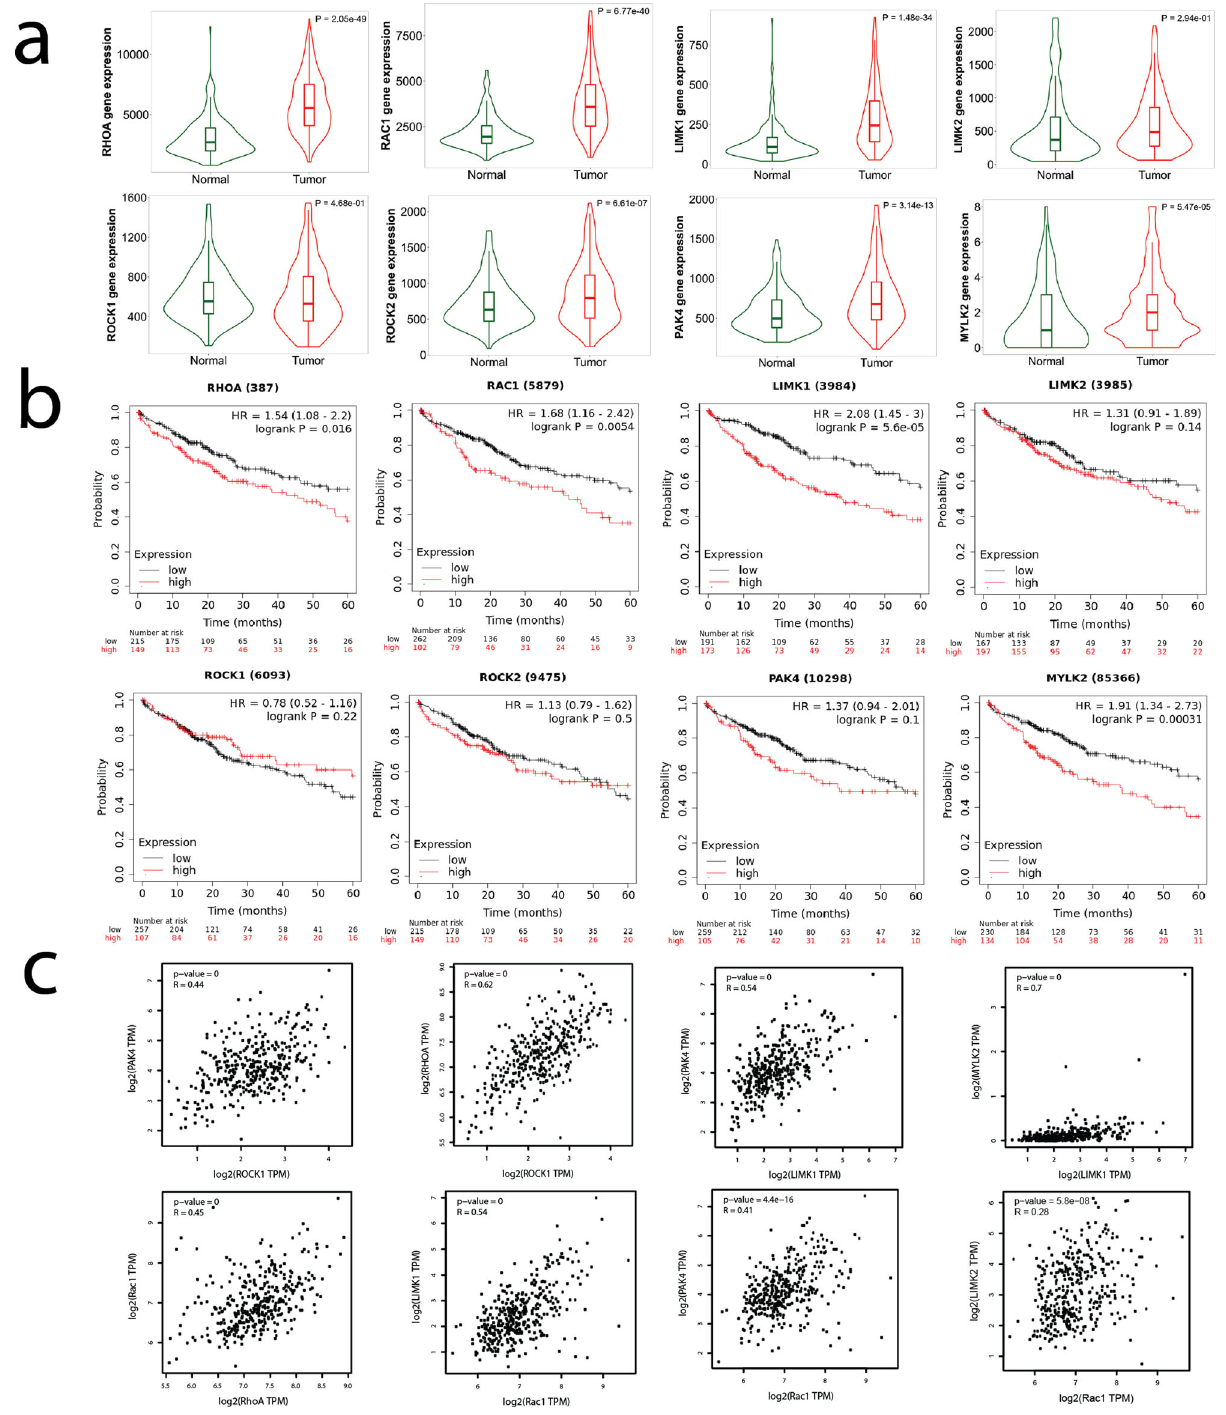
Fig. 7 Rho family of small GTPases, PAK4, LIM kinase, and myosin light chain kinase 2 (MYLK2) are correlated with more invasive liver cancer. a Gene expression levels of RhoA, Rac1, LIMK1, LIMK2, ROCK1, ROCK2, PAK4, and MYLK2 are upregulated in HCC compared to normal liver tissue. b Kaplan – Meier analysis ( n = 364 patients) reveals that RhoA, Rac1, LIMK1, LIMK2, ROCK1, ROCK2, PAK4, and MYLK2 are linked to poor prognosis of HCC. c Correlation analysis shows expressions of Rac1, RhoA, and LIMK1 are positively correlated, suggesting the signaling axes Rac1-LIMK and RhoA- LIMK may be active in HCC. For each correlation plot, p < 10 − 16